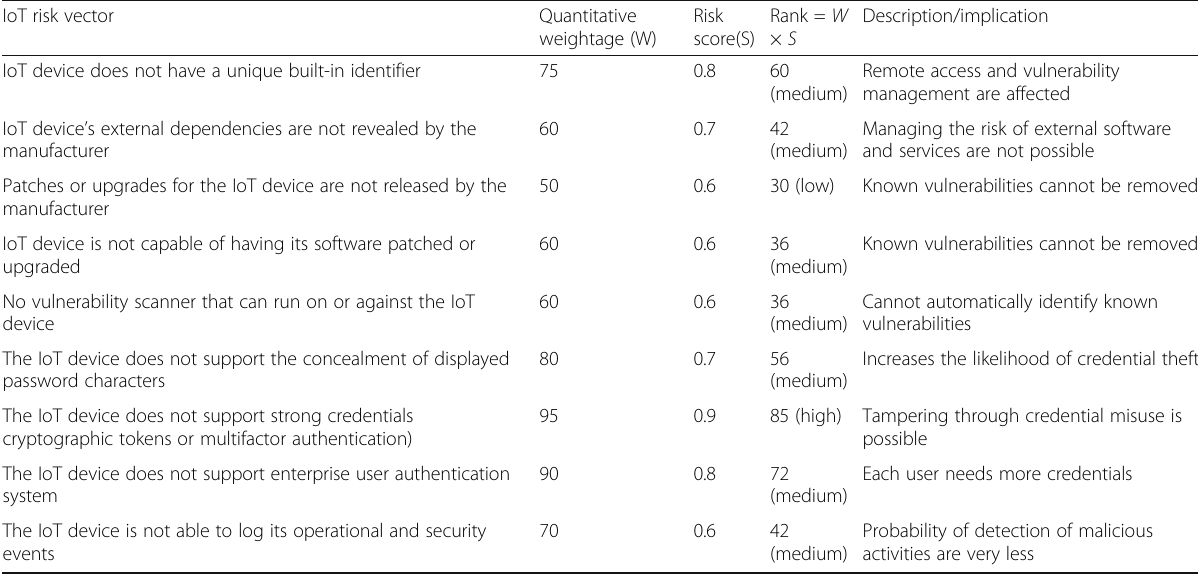
Table 5 Risk rank calculation for IoT device protection IoT risk vector